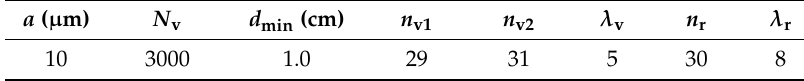
Table 2. Parameters of porosity and rich-resin.